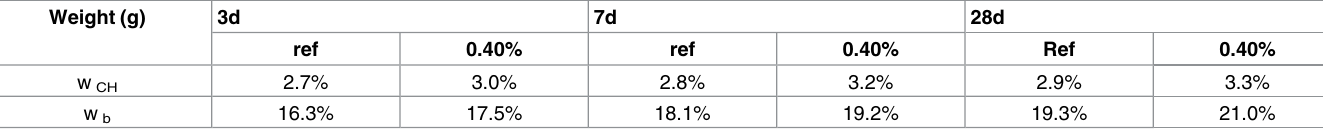
Table 2. W CH and W b contained per gram cement paste with different CNF weight fractions.